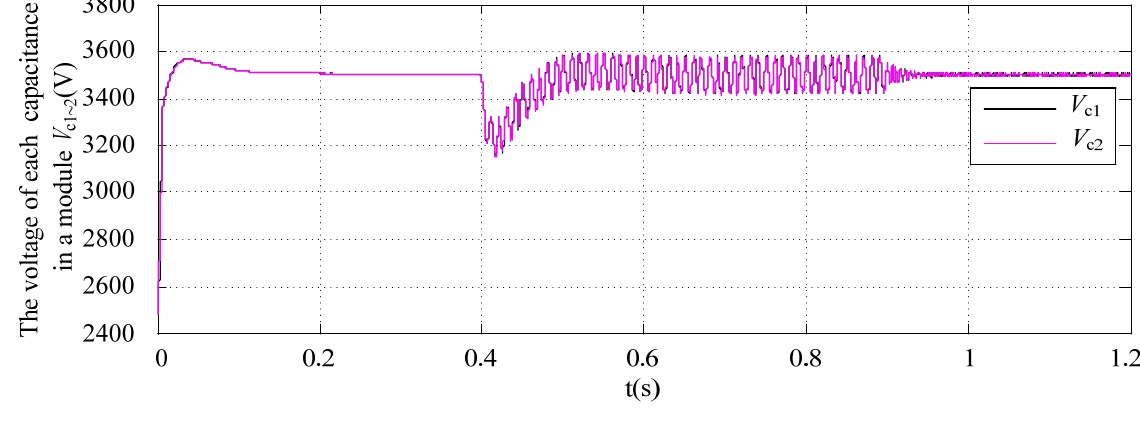
Figure 8. The DC voltage of three-phase to single-phase